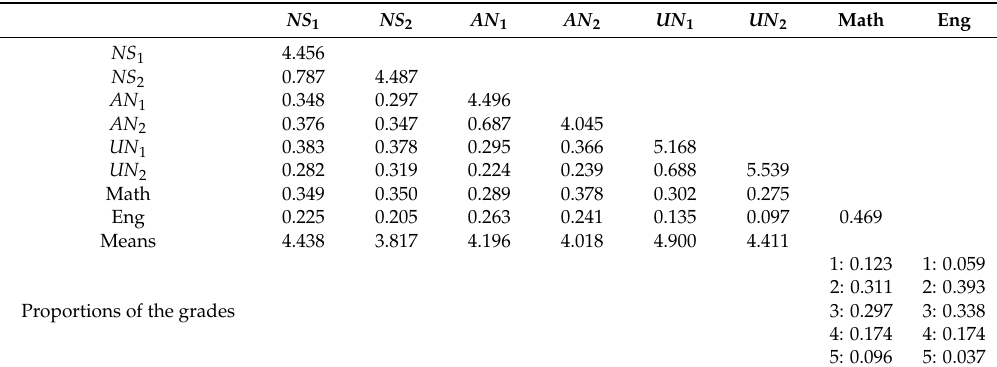
Table 1. Correlations between Observed